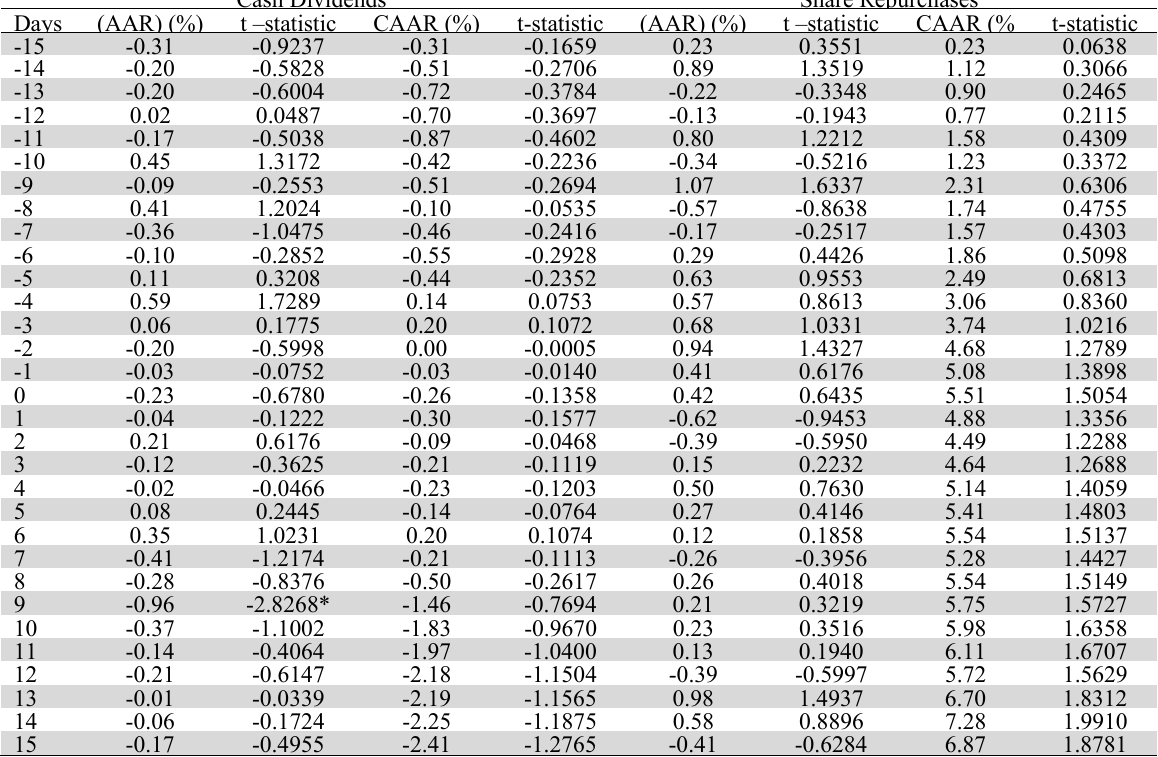
Average Abnormal Returns (AARs) and Cumulative Average Abnormal Return (CAARs) and